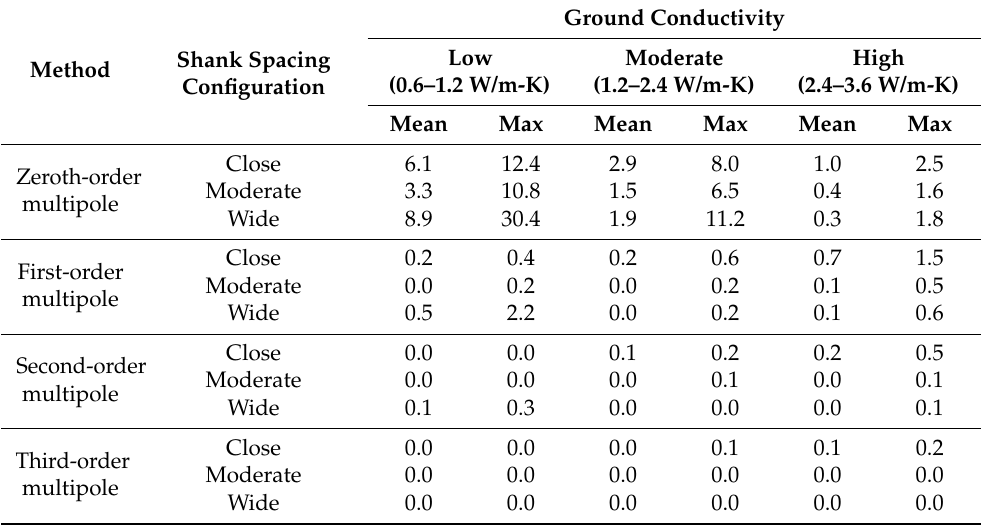
Table 2. Mean and maximum absolute percentage errors in calculation of the grout thermal resistance ( R g ) for the 216 cases provided by